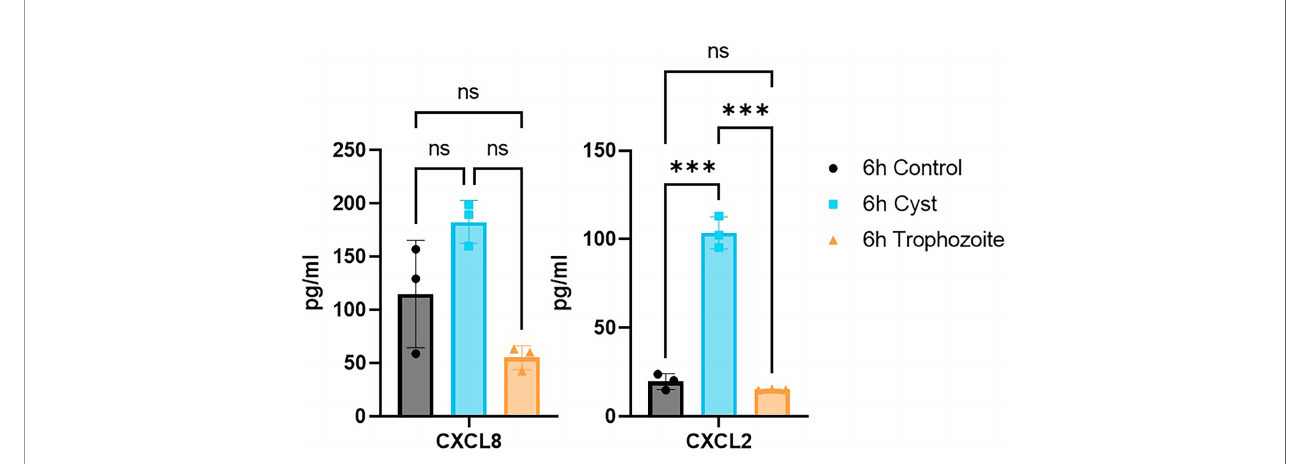
FIGURE 5 | ELISA measurements of chemokines C-X-C chemokine ligand 8 (CXCL8) and C-X-C chemokine ligand 2 (CXCL2) in the culture media after 6h of Caco-2 infections with Giardia trophozoites and cysts. *** P < 0.001; ns, non-signi fi